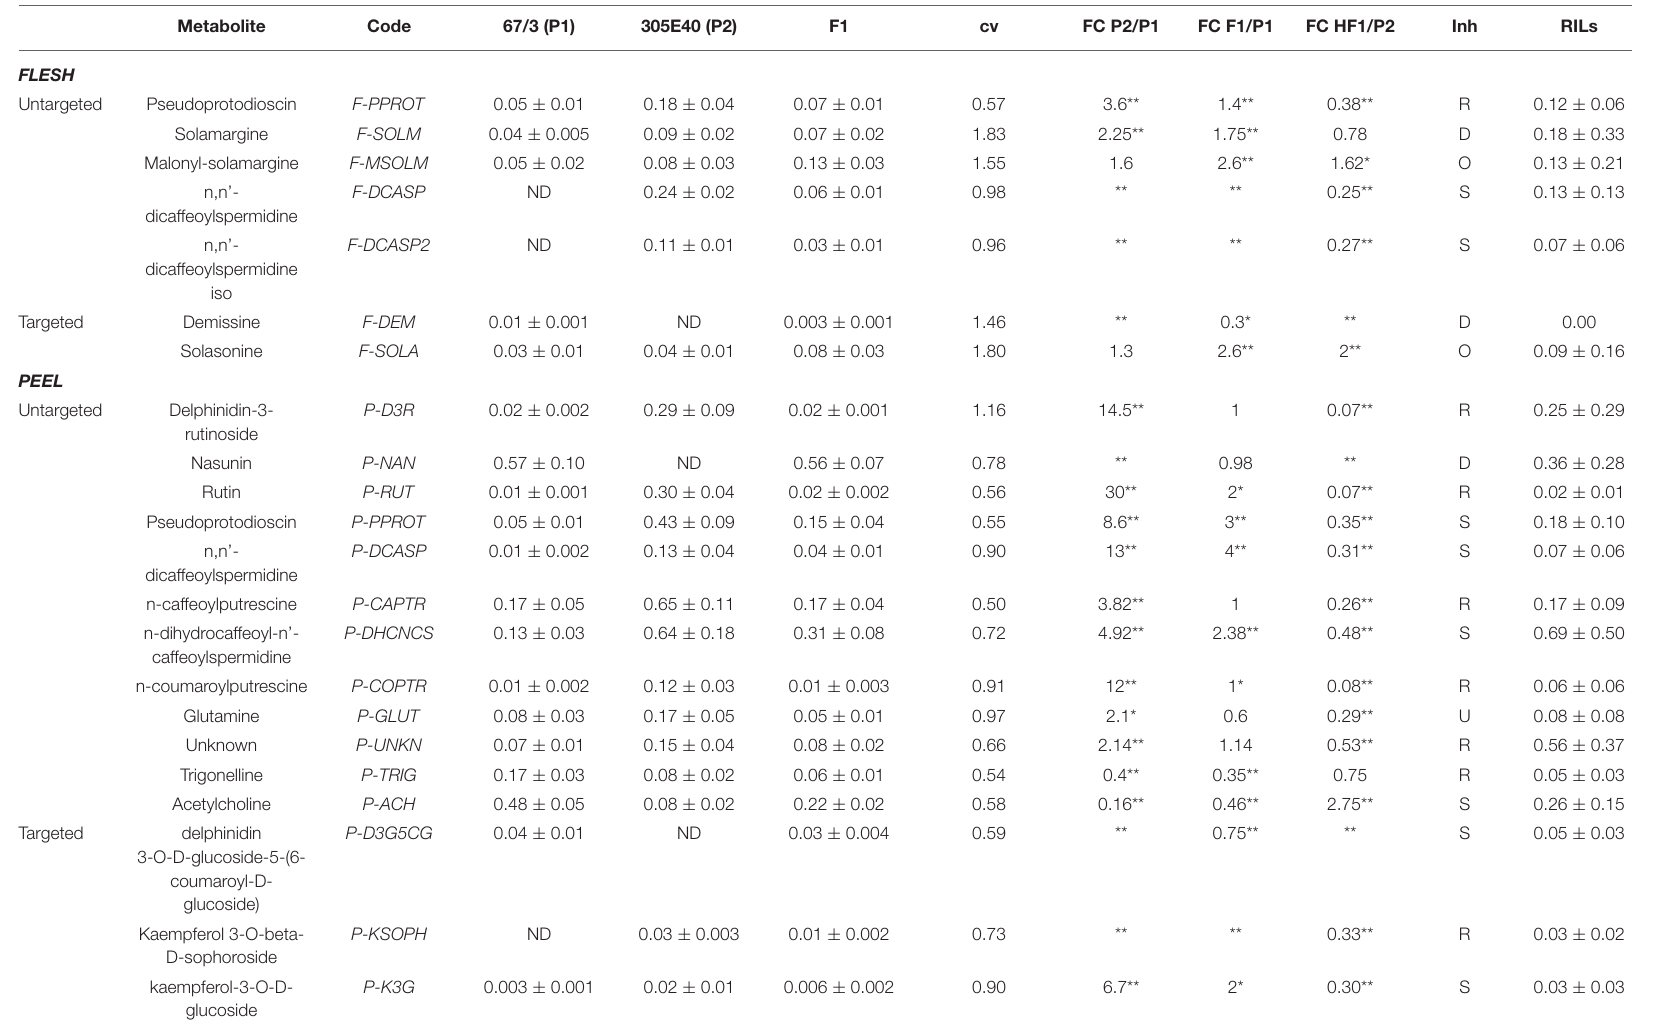
TABLE 1 | Differentially abundant metabolites in flesh and peel extracts of the parental lines, the F1 hybrid and the RIL